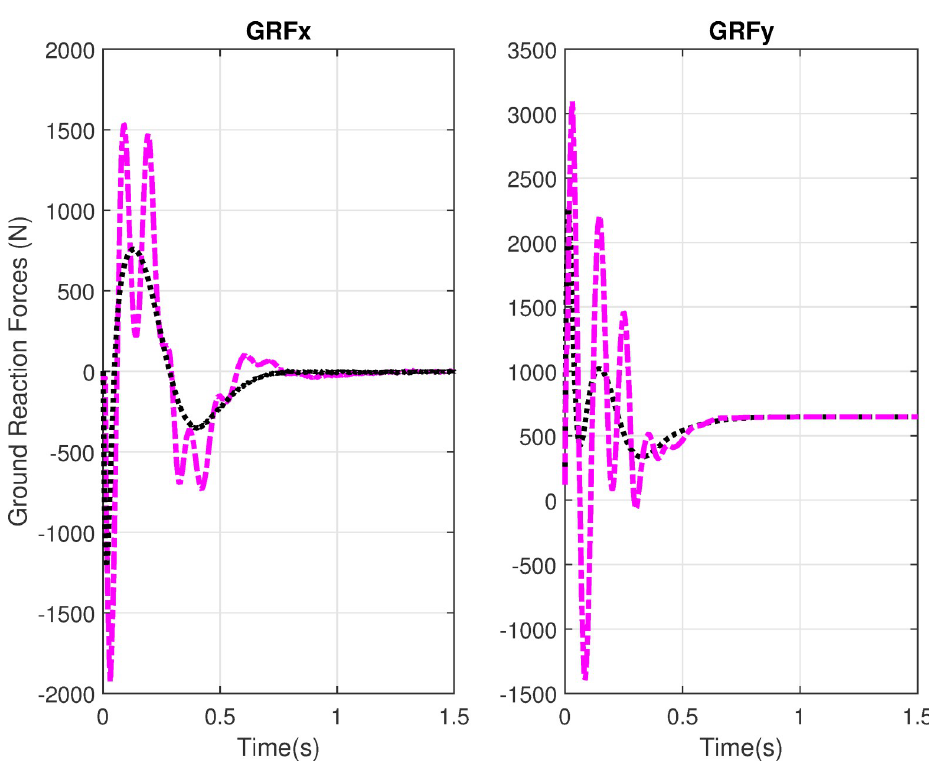
Fig 9. Center-of-mass and center-of-pressure profiles. The normalized horizontal x-COM, vertical y-COM, and horizontal x-COP components. Black lines show the simulations without delays and purple lines show the simulations with delays.